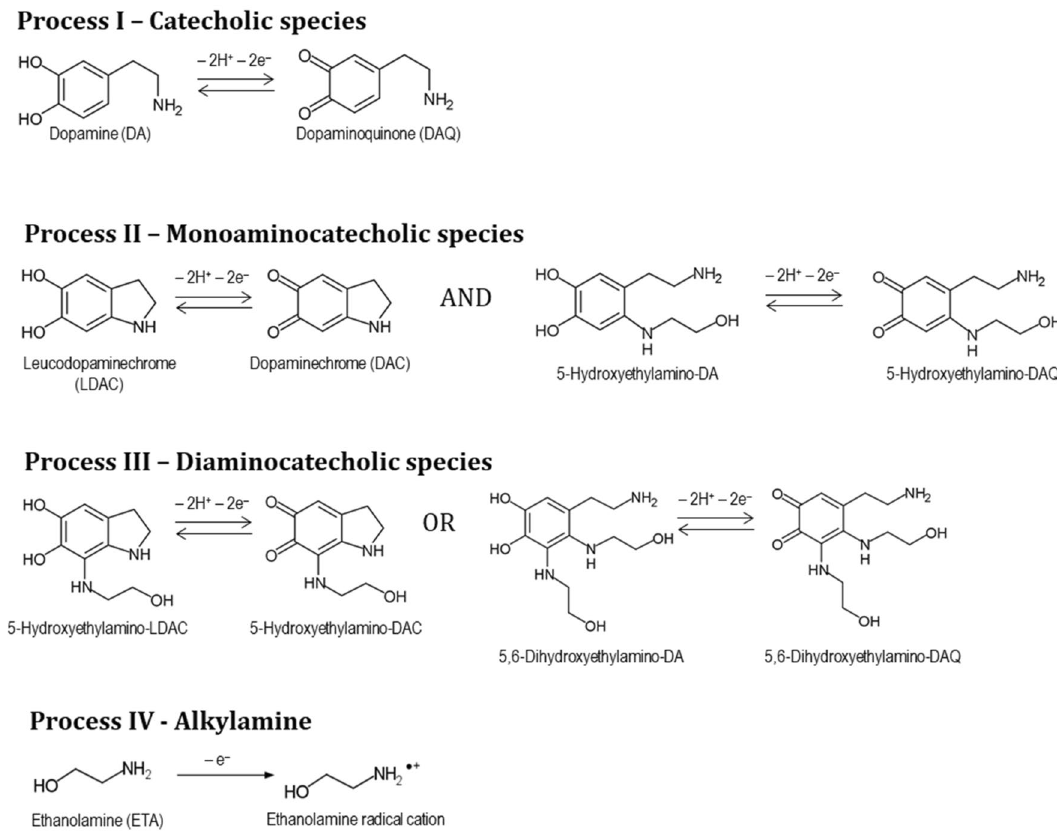
Figure 3. Electrochemical processes of catecholic (I), monoaminocatecholic (II), diaminocatecholic (III), and alkylamine (IV) species possibly occurring in the electropolymerization of dopamine in the presence of